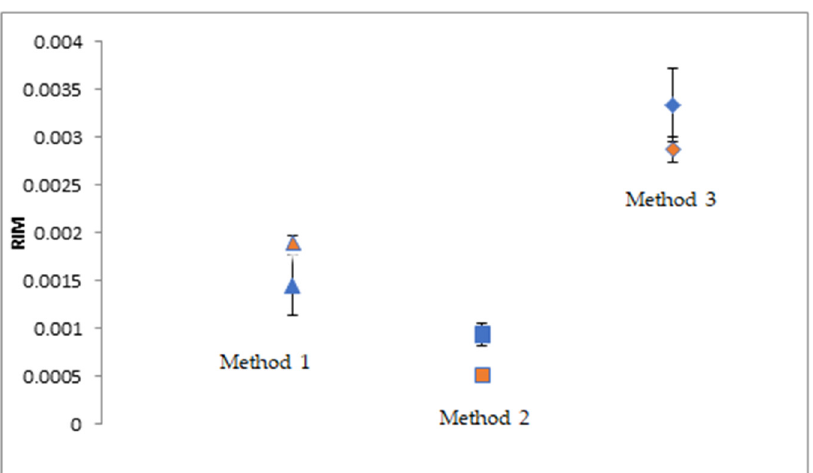
Figure 10. Average RIM values for each method of holographic recording as shown in Table 1. 1: Exposed to laser until full saturation of the diffraction efficiency growth, 2: Short exposure then allowed to complete dark process after, 3: Short exposure then thermally enhanced dark process at 90 °C, blue points for 1 times zirconium concentration and red points for 3 times zirconium concen- tration. Table 2. Summary of Results.